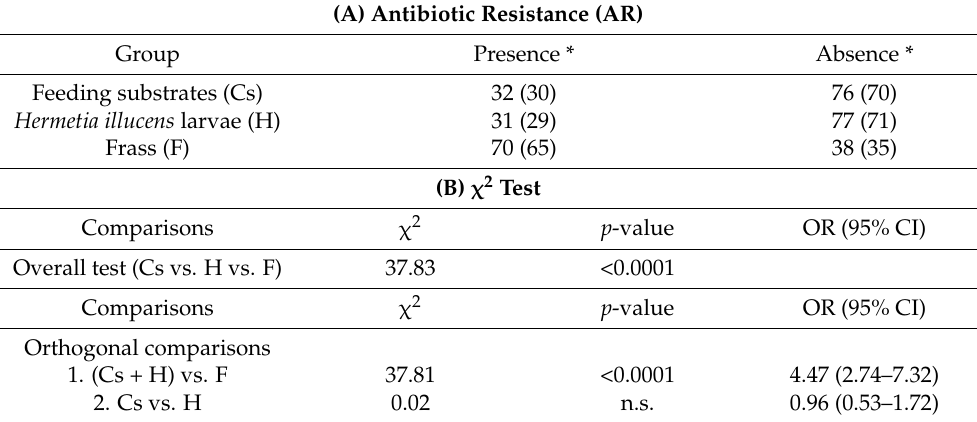
Table 2. Results of the chi-square ( χ 2 ) test: ( A ) AR gene frequencies of each group and ( B ) total χ 2 and orthogonal comparisons.